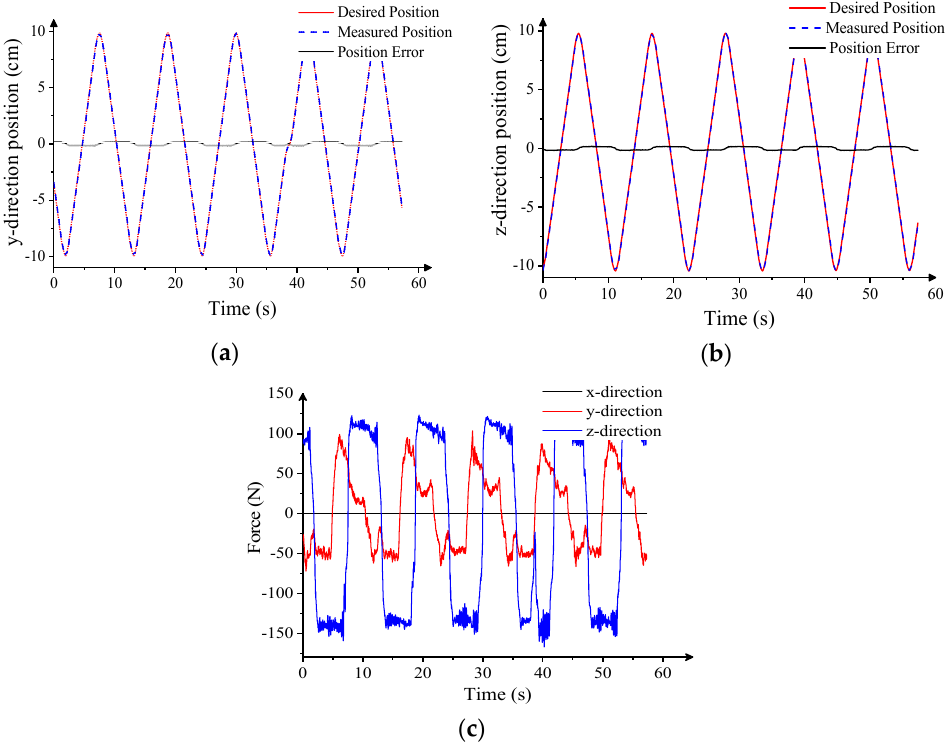
Figure 19. Dynamic tracking experiment: ( a ) y -direction position tracking, ( b ) z -direction position tracking, and ( c ) inertial force.